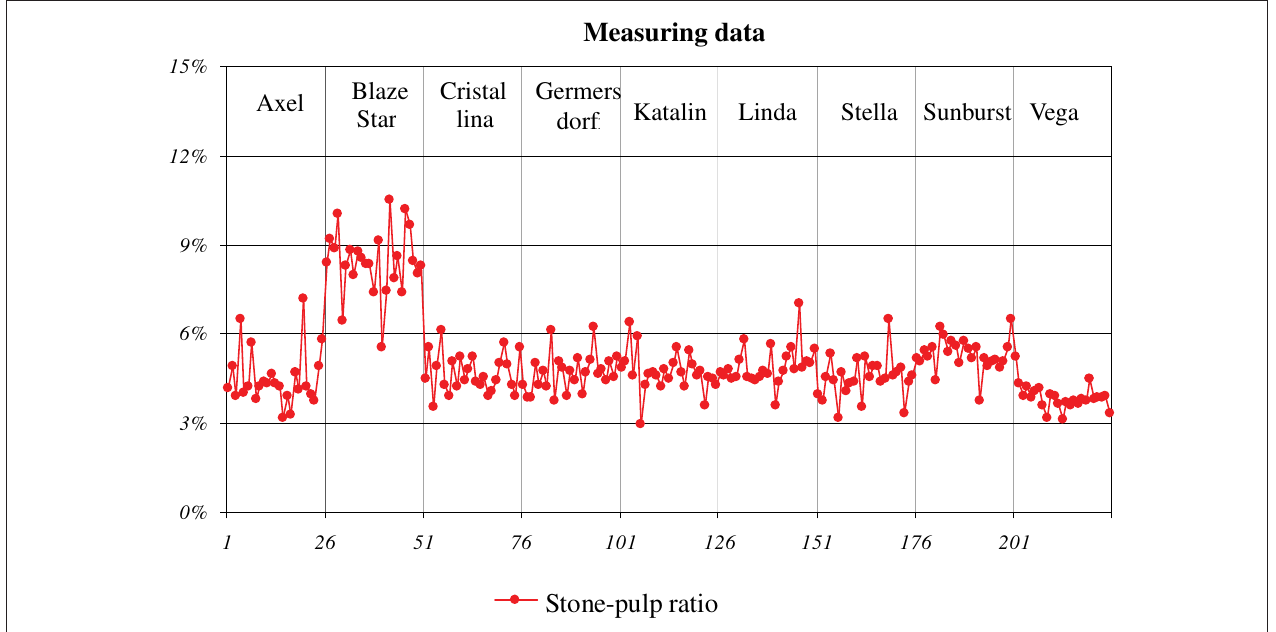
Figure 4. The stone-pulp ratio of the investigated varieties